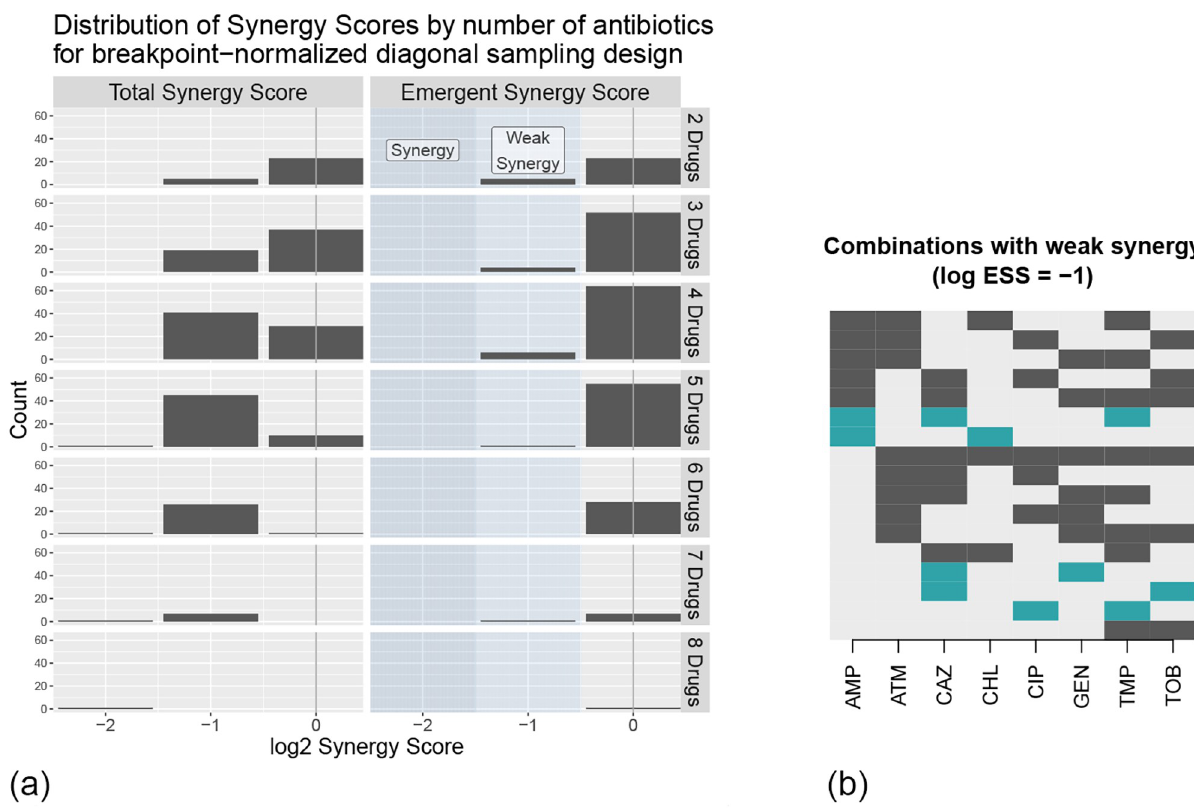
Fig 2. Results from the breakpoint-normalized experiment. (a) Distribution of TSS and ESS scores across all 2 8 different breakpoint-normalized combinations of the eight antibiotics in Table 1, separated by the number of drugs in the combination. (b) Representations of the 17 drug combinations exhibiting weak synergy. Each row represents one combination; dark shades (black and blue) indicate presence of the drug, while light gray indicates absence. Black represents combinations that are weakly synergistic according to the breakpoint normalization but not the MIC normalization (next section), while blue shows the five combinations that exhibited weak synergy according to both